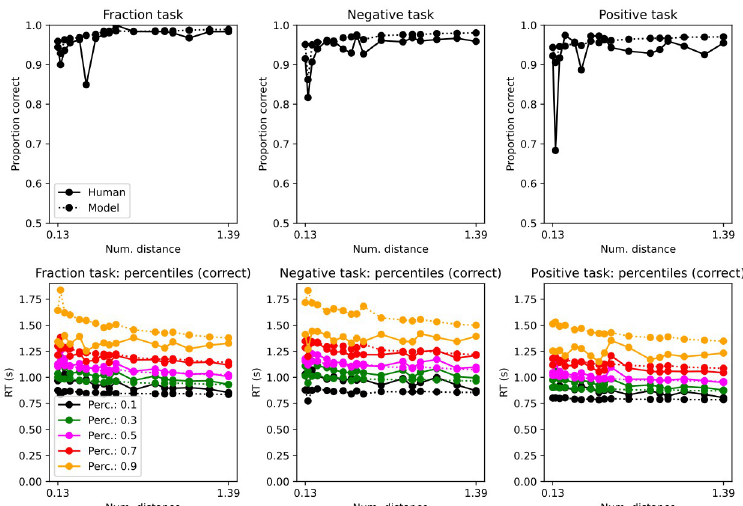
Fig 10. Accuracy (top) and response time distributions by percentiles (bottom) by trial type (Exp 3.). Numerical distance in log. scale. Response times are for correct trials; see Supplemental Information for incorrect trials.